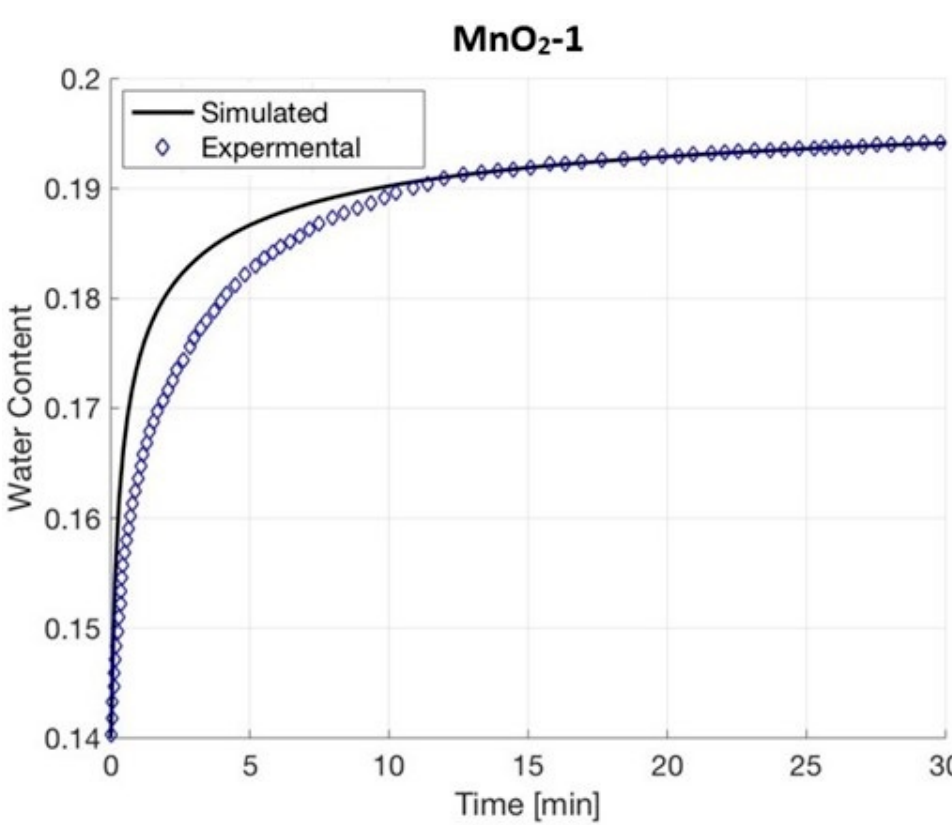
Figure 14. Comparison of HAW model of MnO 2 -1 (b) [10]. The relative error of the proposed model was determined to demonstrate its validity and robustness. Table 4 shows the maximum and minimum errors and the average for all the relative error points. The maximum error of the harvesting atmospheric water model of copper chloride is around 1.29%, the minimum error is about 0.025%, and the average error of the HAW model of copper chloride is 0.49%. Furthermore, the maximum error of the HAW model of copper sulfate is around 0.77%, the minimum error is about 0.01%, and the average error of the HAW model of copper sulfate is 0.31%. In addition, the maximum error of the HAW model of magnesium sulfate is around 1.4%, the minimum error is about 0.001%, and the average error of the HAW model of magnesium sulfate is 0.66%. Further, the maximum error of the HAW model of MnO2-1 is around 7.72%, the minimum error is about 0.001%, and the average error of the HAW model of MnO 2 -1 is 1.88%.